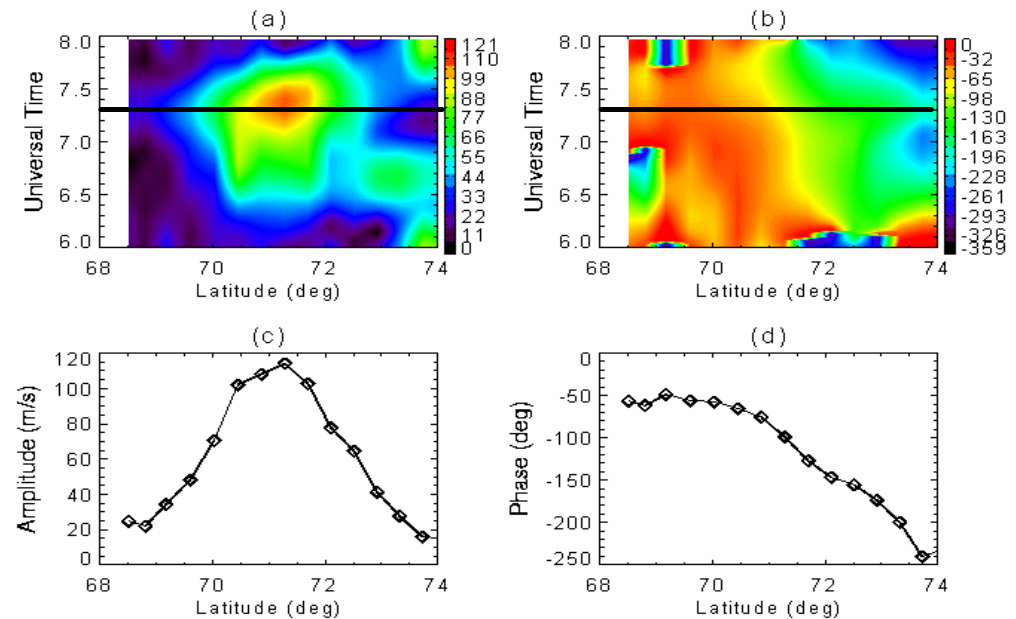
Fig. 3. The instantaneous amplitude (a) and phase (b) of the 1.9mHz component as a function of latitude from Goose Bay data calculated as the amplitude and phase of the analytic signal respectively. The length of the signal is 2h sampled at 120s intervals. Panels (c) and (d) represent the cut through the instantaneous amplitude and phase at 7.3UT (where amplitude is maximum) indicated by dark lines in panels (a) and (b). Panel (c) shows an enhancement in amplitude of this component across the resonance latitude of 71.3 ◦ while panel (d) shows a 180 phase change across the resonant